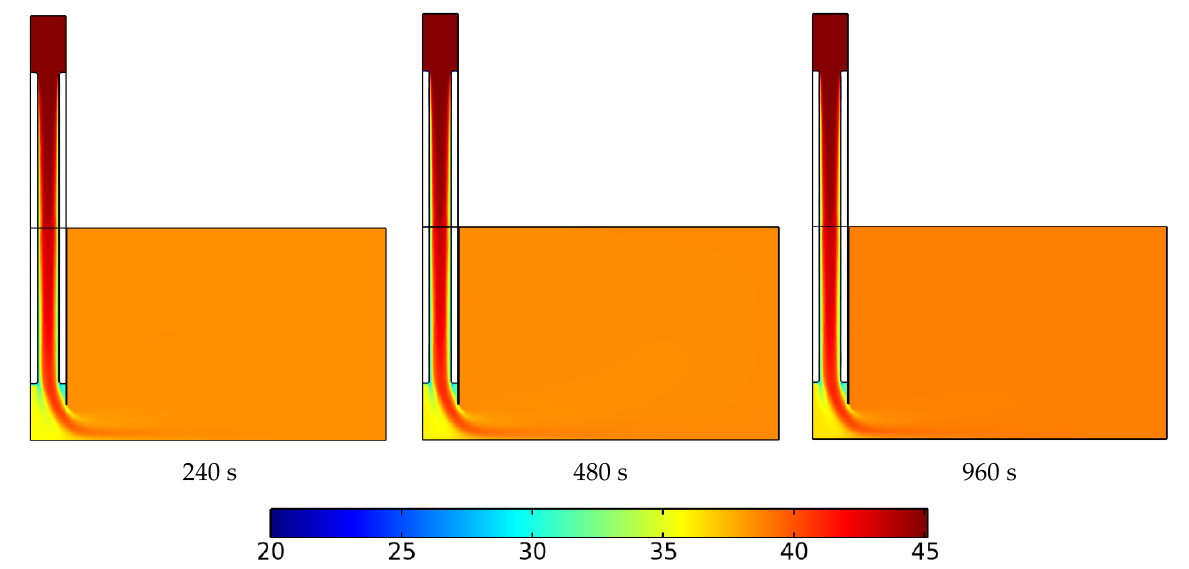
Figure 5. Temporal evolution of the temperature field for case 3; u in = 0.5 m/s, and T in = 45 °C.